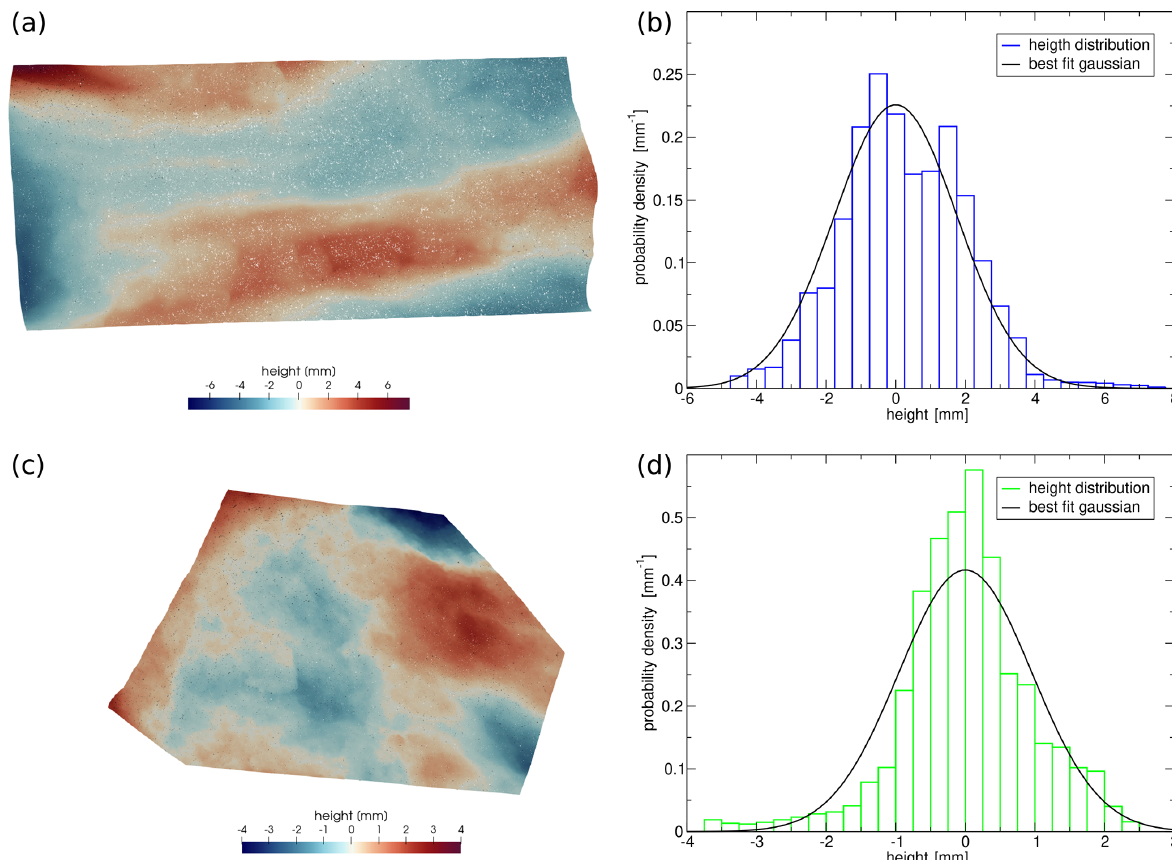
Figure 13. Distribution of heights for fracture surfaces generated in laboratory deformation experiments. Top: limestone sample deformed at σ 2 = σ 3 = 30MPa, bottom: sandstone sample deformed in unconfined compression test. (a) Map view of the limestone surface colored by height above the “best-fit” plane. (b) Probability density of heights and fitted normal distribution for limestone surface (c) Map view of the sandstone surface colored by height above the “best-fit” plane. (d) Probability density of heights and fitted normal distribution for sandstone surface.